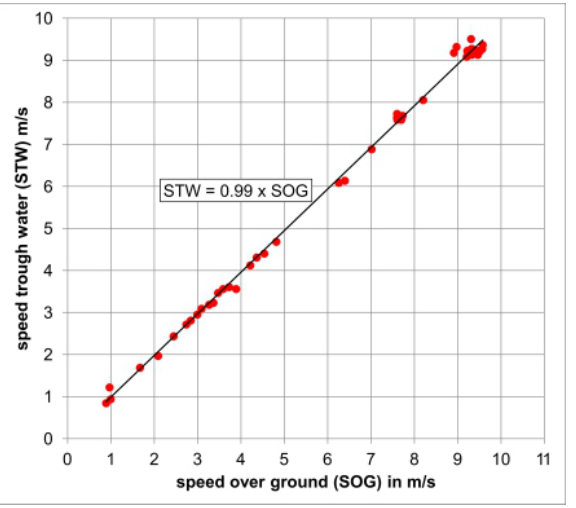
Figure 8. GNSS-derived speed over ground (SOG) and manually recorded speed through water (STW) of the cruise vessel.